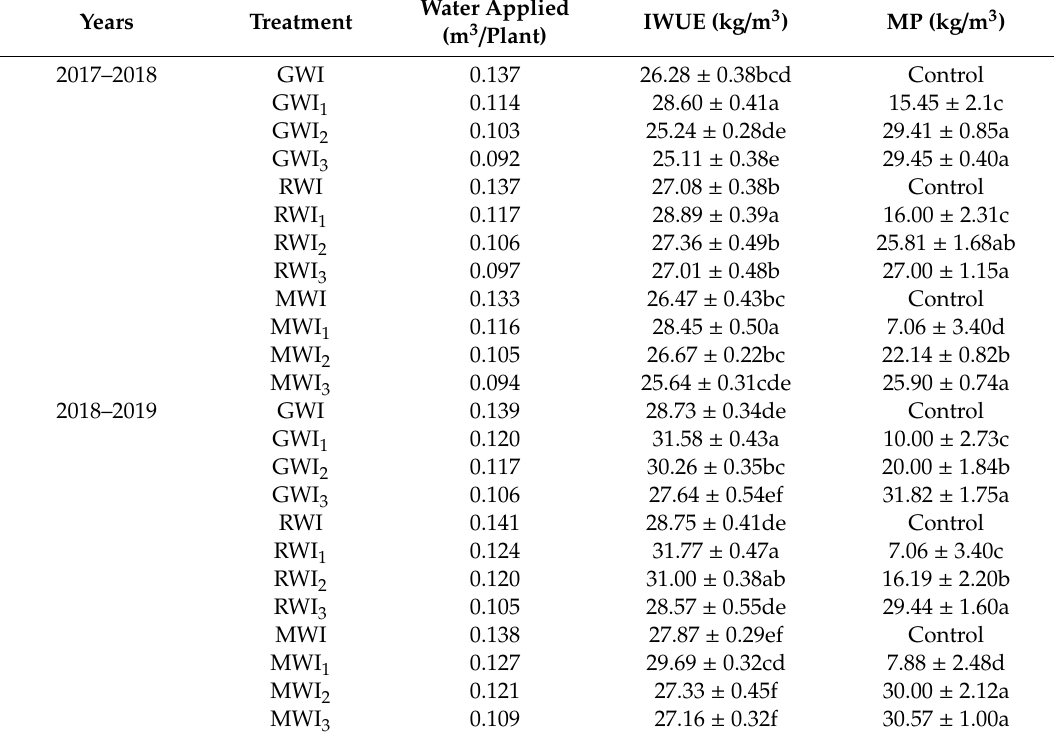
Table 8. Descriptive statistics of IWUE and MP across three water qualities and four irrigation